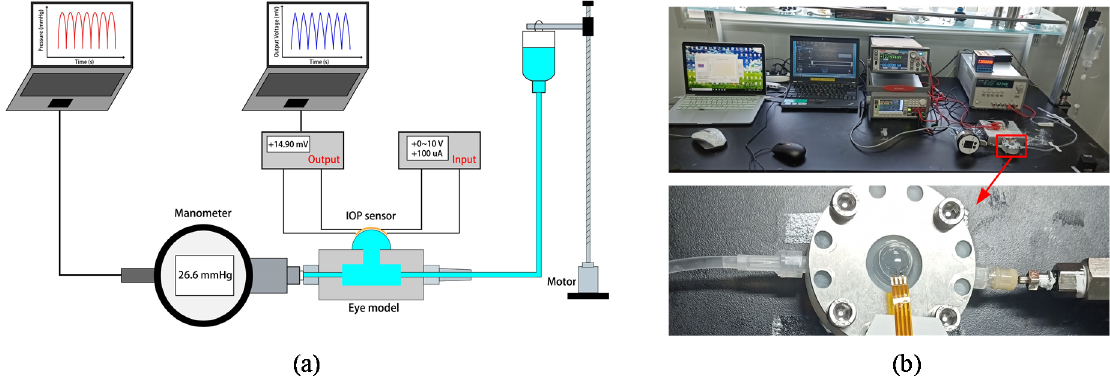
Figure 4. ( a ) Schematic diagram of the IOP test system. ( b ) Physical photo of the IOP test